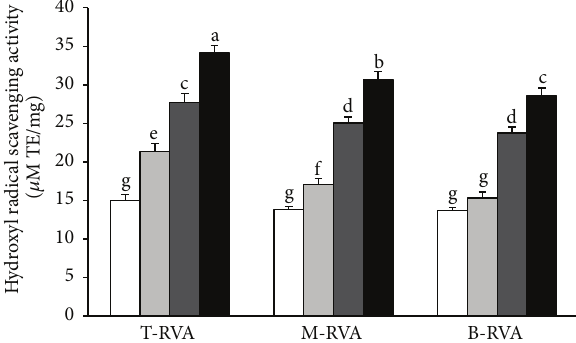
Figure 3: The effect of RVA on hydroxyl radical scavenging activity. a – g Values not sharing a common letter are significantly different at 𝑃 < 0.05 by Dunnett’s multiple range tests. Light gray square, 125 𝜇 g/mL; gray square, 250 𝜇 g/mL; dark grey square, 500 𝜇 g/mL; black square, 1,000 𝜇